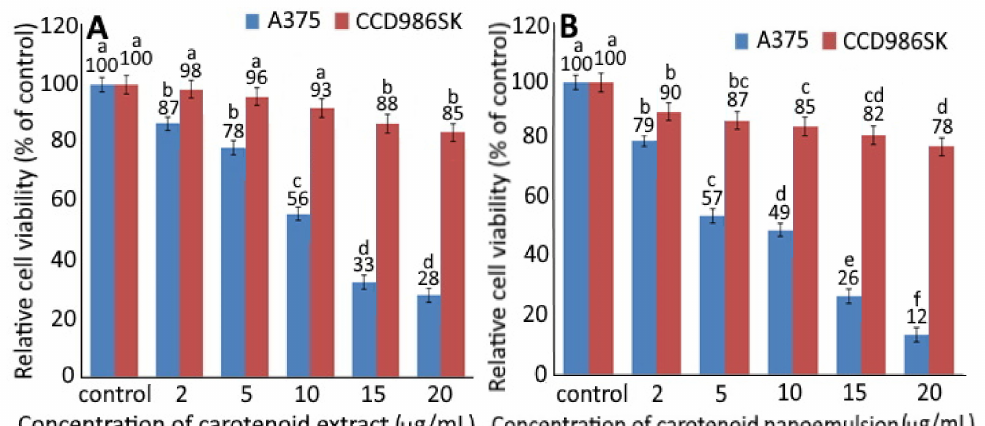
Figure 3. Relative cell viability of human melanoma cells A375 and fibroblast cells CCD986SK as affected by different concentrations of carotenoid extract ( A ) and carotenoid nanoemulsion ( B ) after 48 h incubation as measured by MTT assay. For control, cells were incubated in a medium containing 1% DMSO. Data shown are mean ± standard deviation ( n = 3). Data with different small letters (a–f) in the same treatment but with different concentrations are significantly different ( p < 0.05).